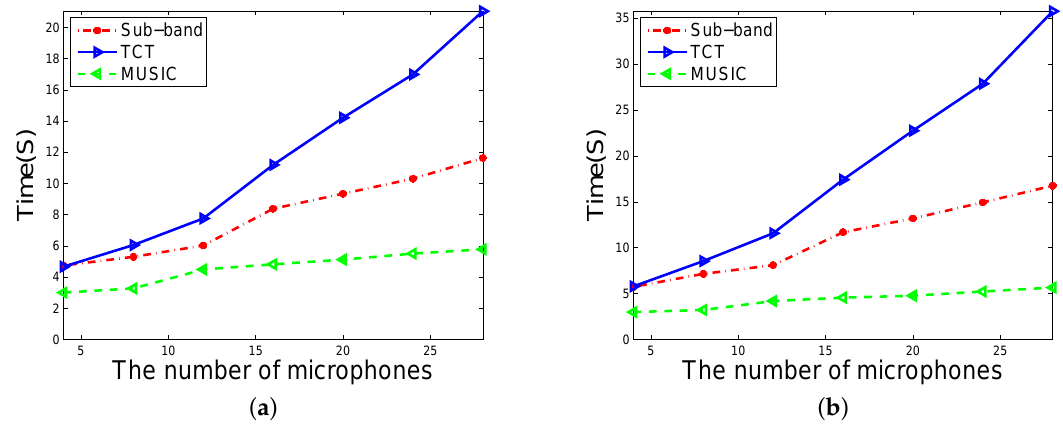
Figure 7. The time elapse of the three DOA estimation methods under 1000 estimations. ( a ) J = 8; ( b ) J =